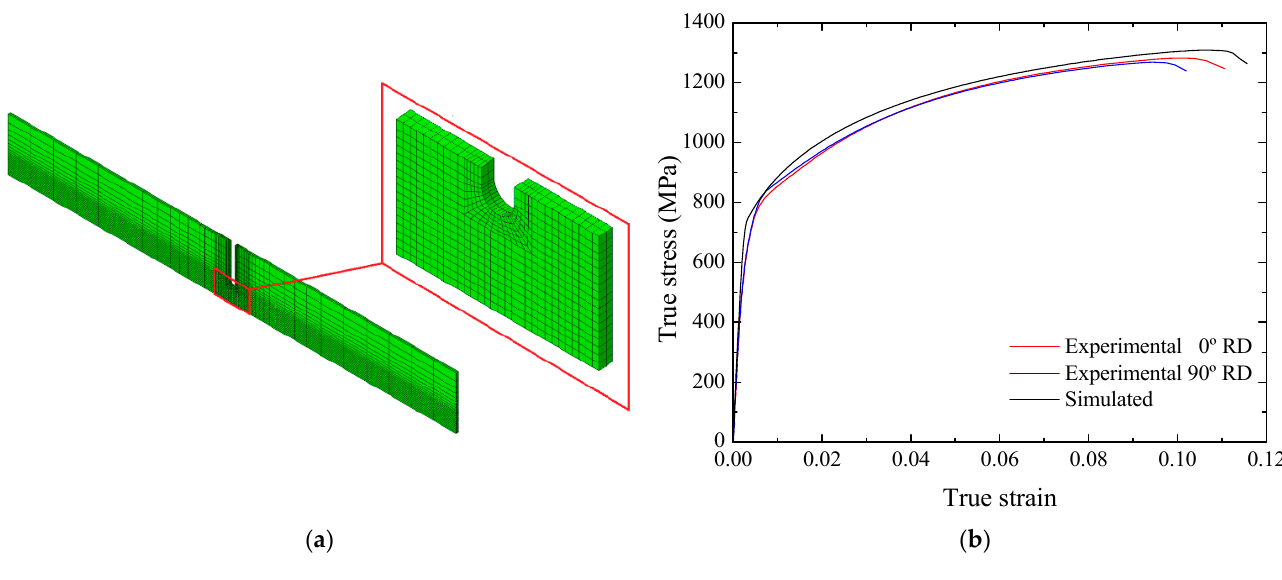
Figure 22. ( a ) Mesh refinement adopted in the flat double-notched specimen, and ( b ) experimental true stress–strain curve of the plane strain test and predicted results obtained with the complete set of parameters of the GTN model.